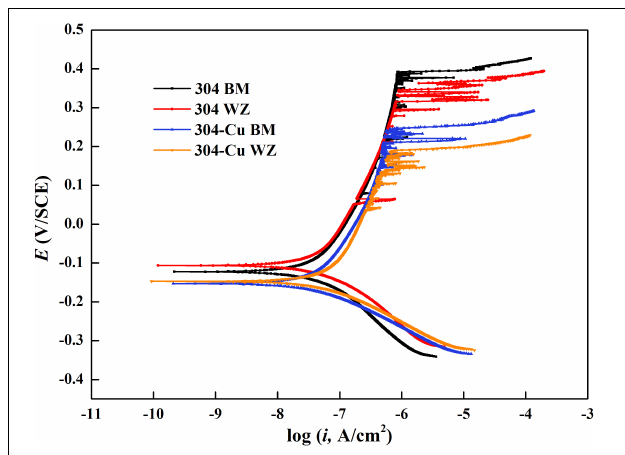
FIGURE 2 | Potentiodynamic polarization curves of base metals and welding zones of 304L and 304L-Cu SS in 3.5% NaCl solution. SS, stainless steel.